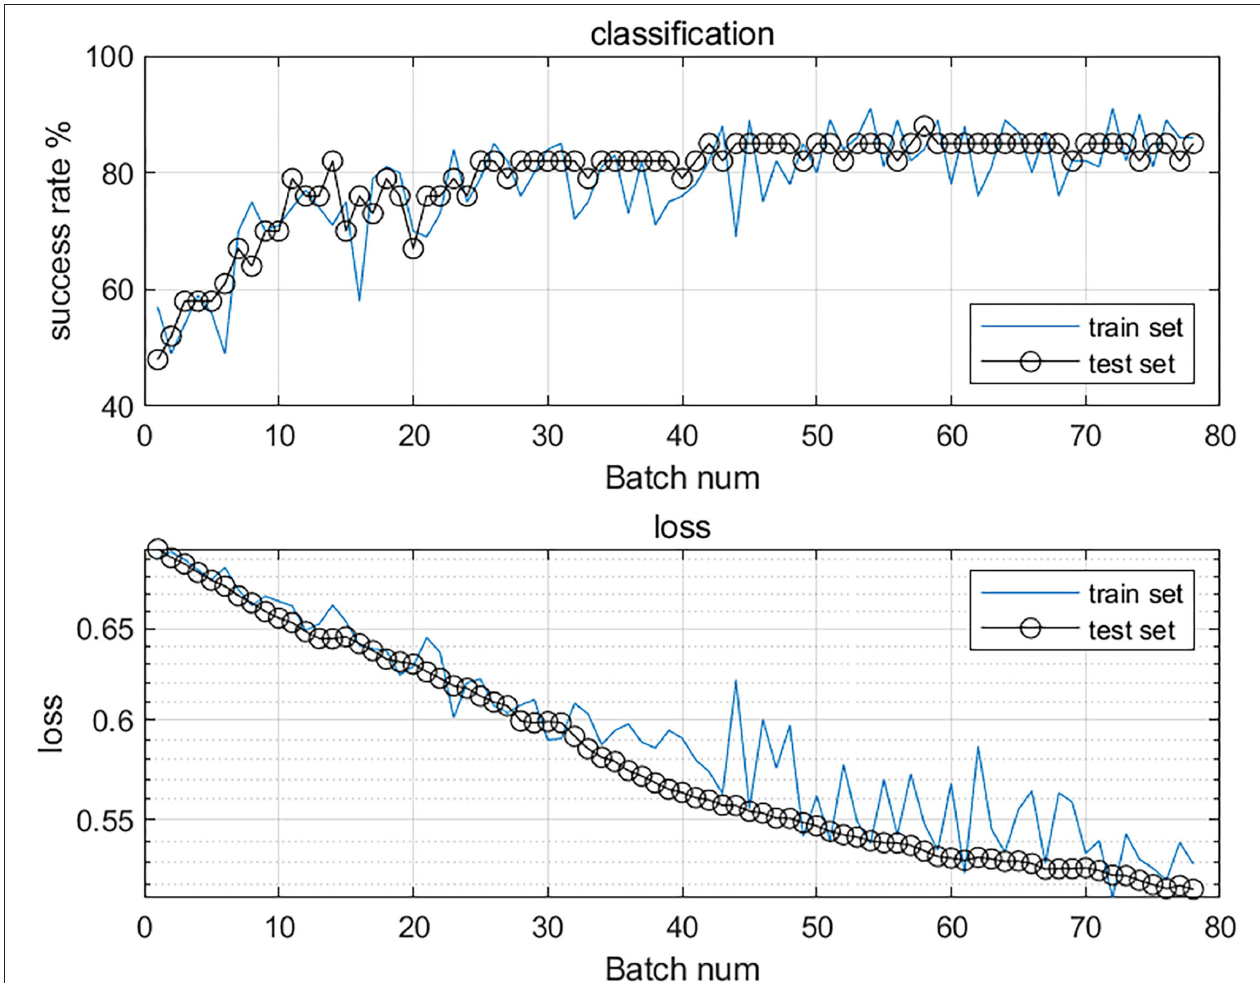
FIGURE 2 | The accuracy and loss value curves of the classification model. The top curve shows the overall success rate, the increasing success rate proves that its accuracy is improving. The bottom curve shows the loss curves of the training and test sets, the loss value is decreasing, which proves that the model is converging and has good